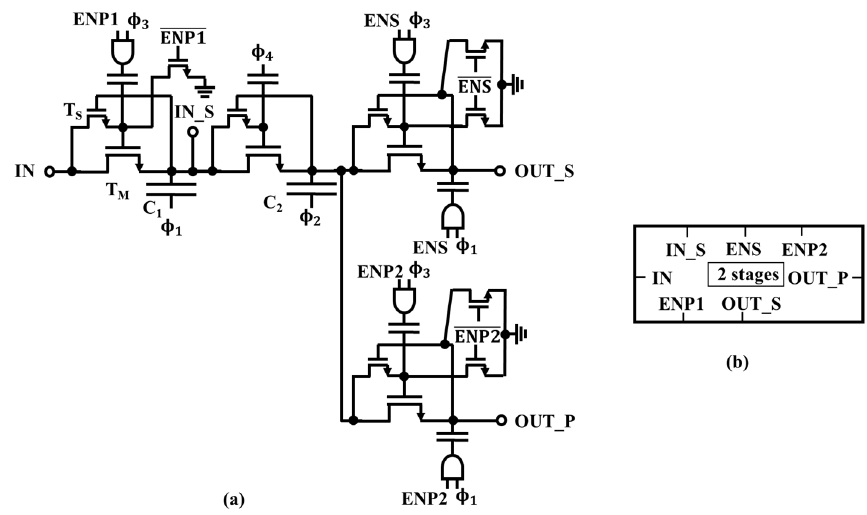
Figure 4. ( a ) Two-stage unit; ( b ) symbols of the two-stage unit.